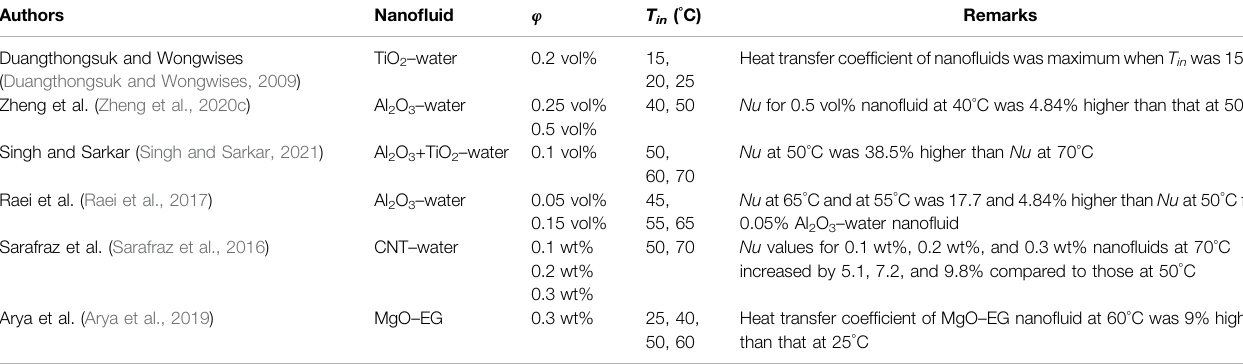
TABLE 8 | Effects of inlet temperature on heat transfer characteristics of nano fl uids in double-tube heat exchangers.